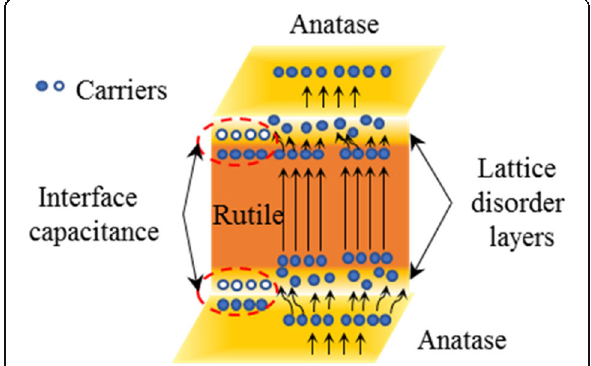
Fig. 12 Sketch of the carrier transfer within H@TNAs with mixed crystal